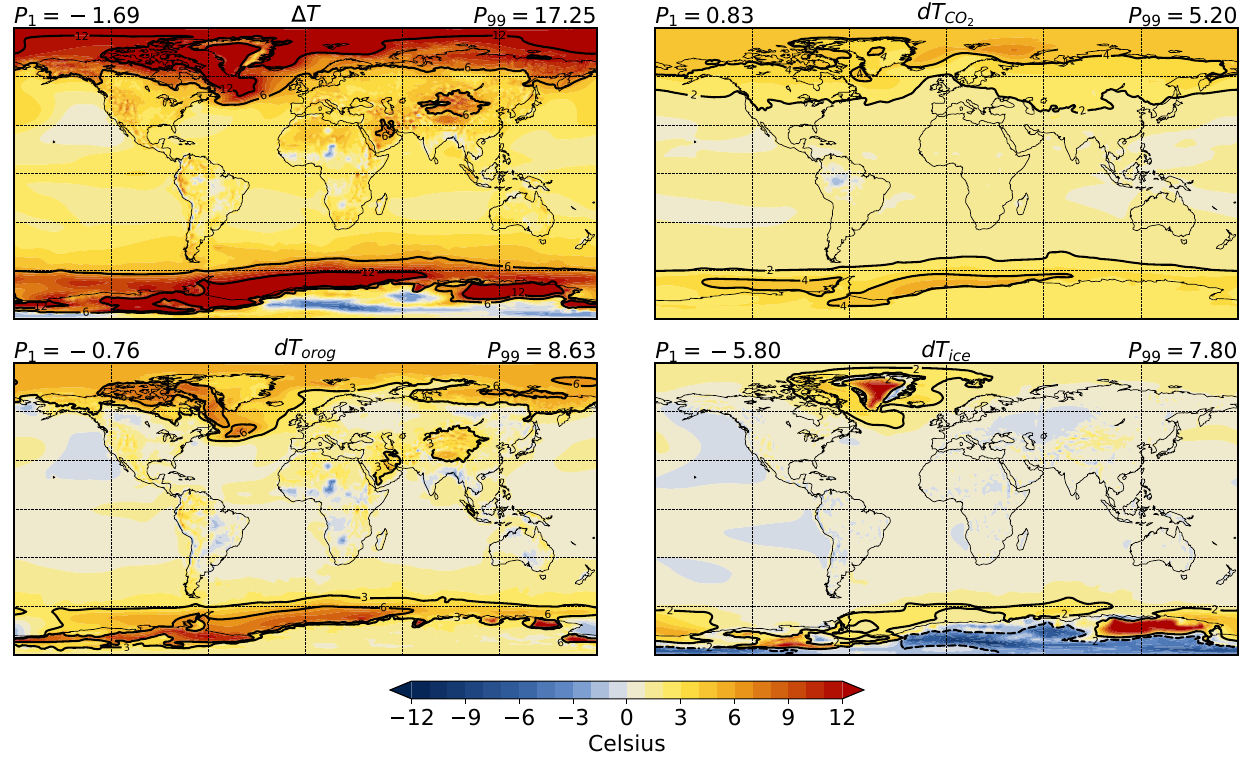
Figure 7. MASAT anomaly between the mid-Pliocene and the PI ( (cid:49)T ) and its factorization into contributions from changes in atmospheric p CO 2 (d T CO ), orography (d T orog ), and ice sheet configuration (d T ice ) using Eq. (2). The 1st and the 99th percentiles of the quantities 2 plotted are shown above each panel.